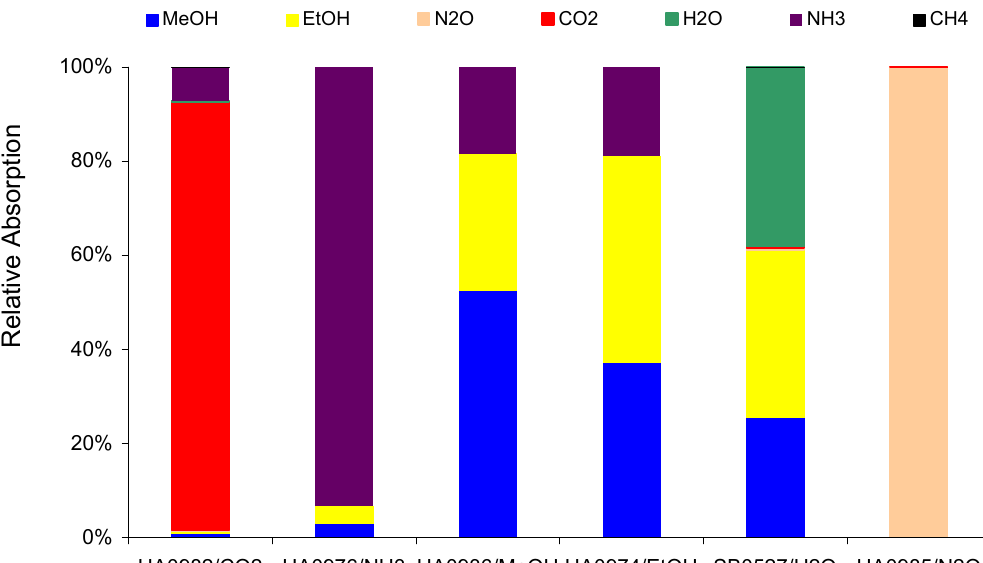
Figure 5. Relative absorption of 1 ppm non-target CH filter in Example #2.